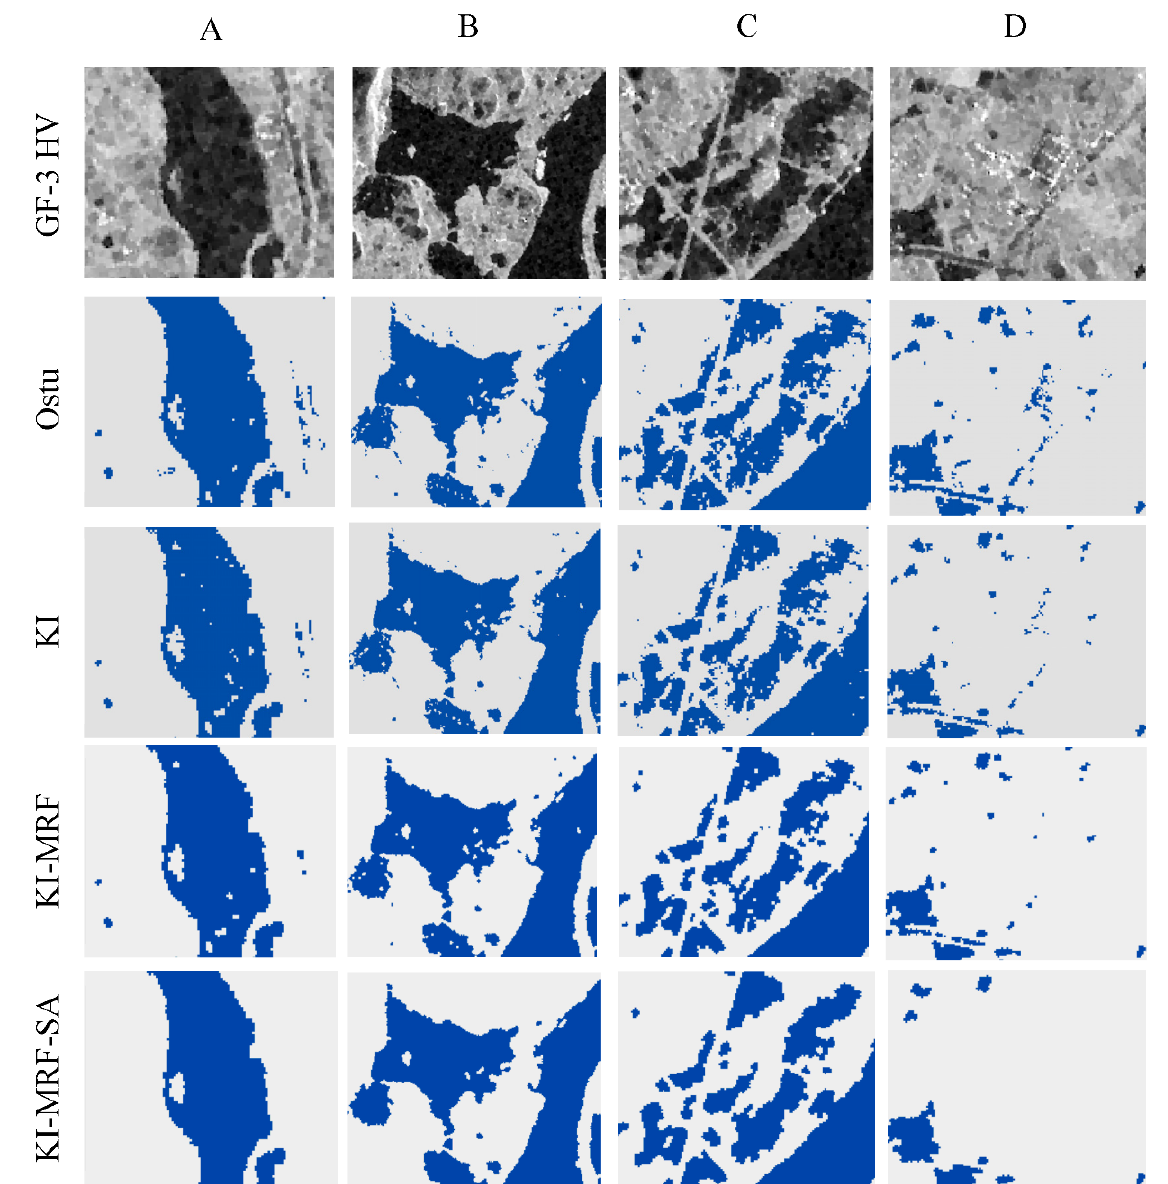
Figure 7. Detail displays of water extraction in Boluokeng. The subfigures ( A – D ) are some remarkably changed spots in Boluokeng.